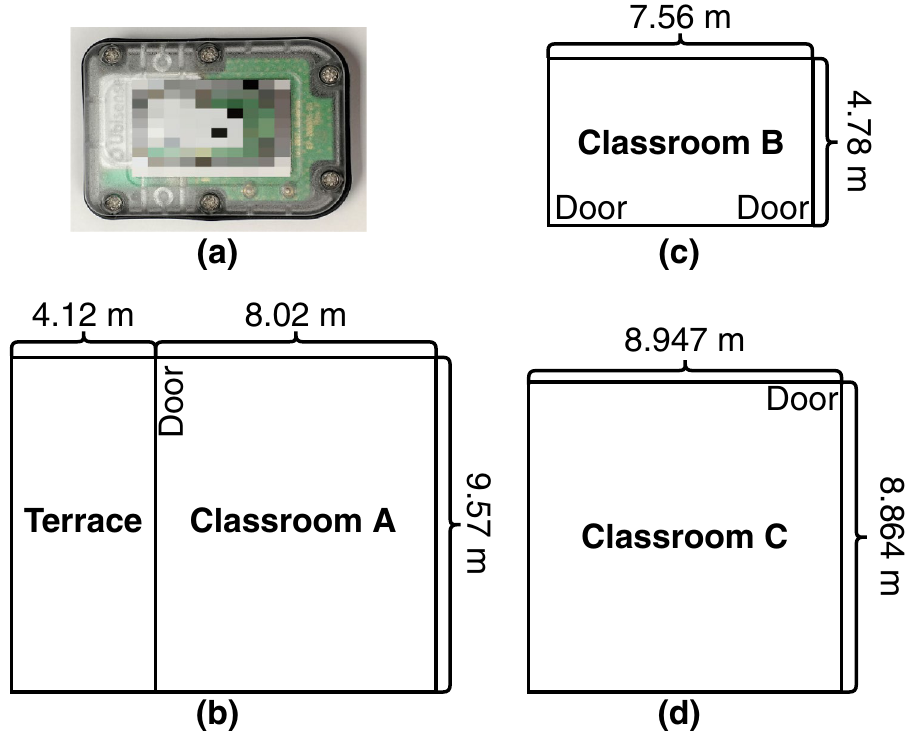
Figure 1. ( a ) Ubisense tag worn by the teachers and children in the classrooms; Layout of Classrooms for ( b ) Class A; ( c ) Class B and ( d ) Classes C & D (Classes C & D occupied the same classroom in successive